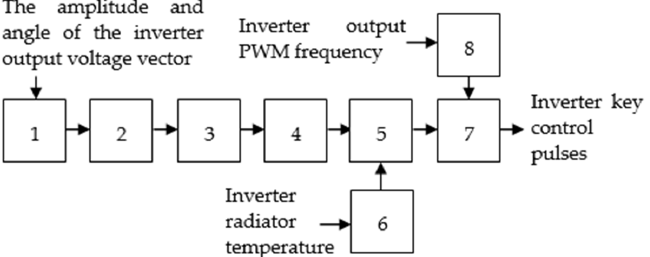
Figure 1. Flowchart of the developed three-phase voltage source inverter control method: 1—sector determining unit; 2—angle inside the sector determining unit; 3—time evaluation unit of base vector connection and the pause time; 4—phase voltage envelope curve calculating unit; 5—phase voltage envelope curve modification unit; 6—angles of connection calculating unit; 7—switch control pulse-generating unit; 8—PWM triangular reference voltage shaping unit.